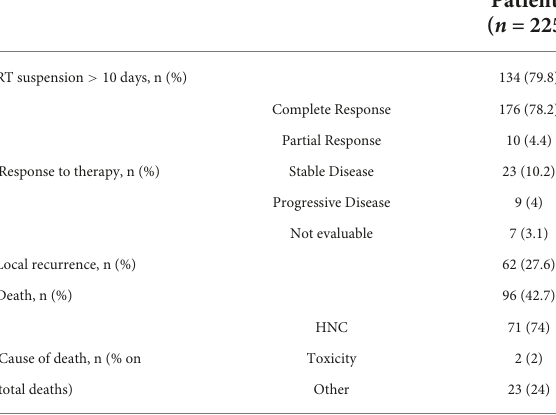
TABLE 1 Study cohort description, including patients’ clinical characteristics, main cancer features, radiation treatment type, and main